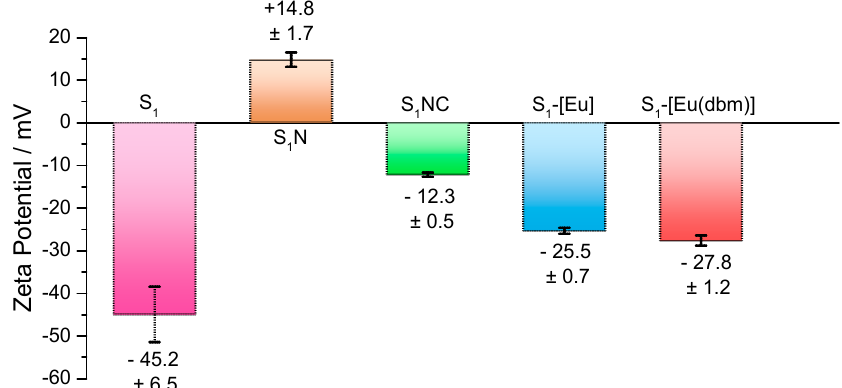
Figure 4. Zeta potential (pH = 7.64) for the particles synthesized in each functionalization step.